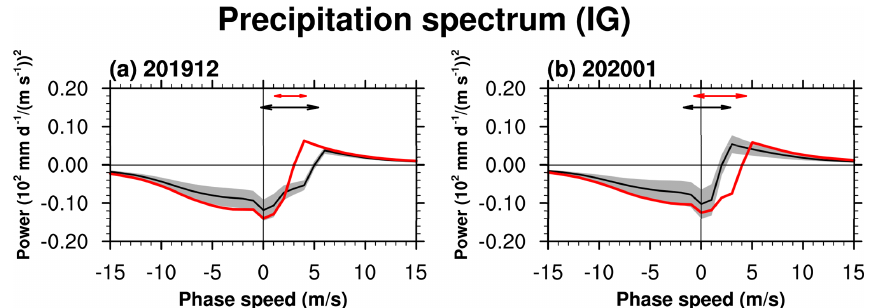
Figure 11. The 10 ◦ S to 10 ◦ N averaged precipitation spectrum for the IG wave range [(i) | k | > 20 and ω > 0cpd or (ii) | k | ≤ 20 and ω > 0 . 4cpd] as a function of phase speed in (a) December 2019 and (b) January 2020 along with the corresponding monthly climatology (black) and ± 1SD (gray shading). The spectrum with a negative sign represents the westward-propagating waves. Double-sided arrows in the upper part of each panel indicate the zonal wind ranges between 140hPa (i.e., source level) and 70hPa for the QBO disruption period (red) and climatology (black).